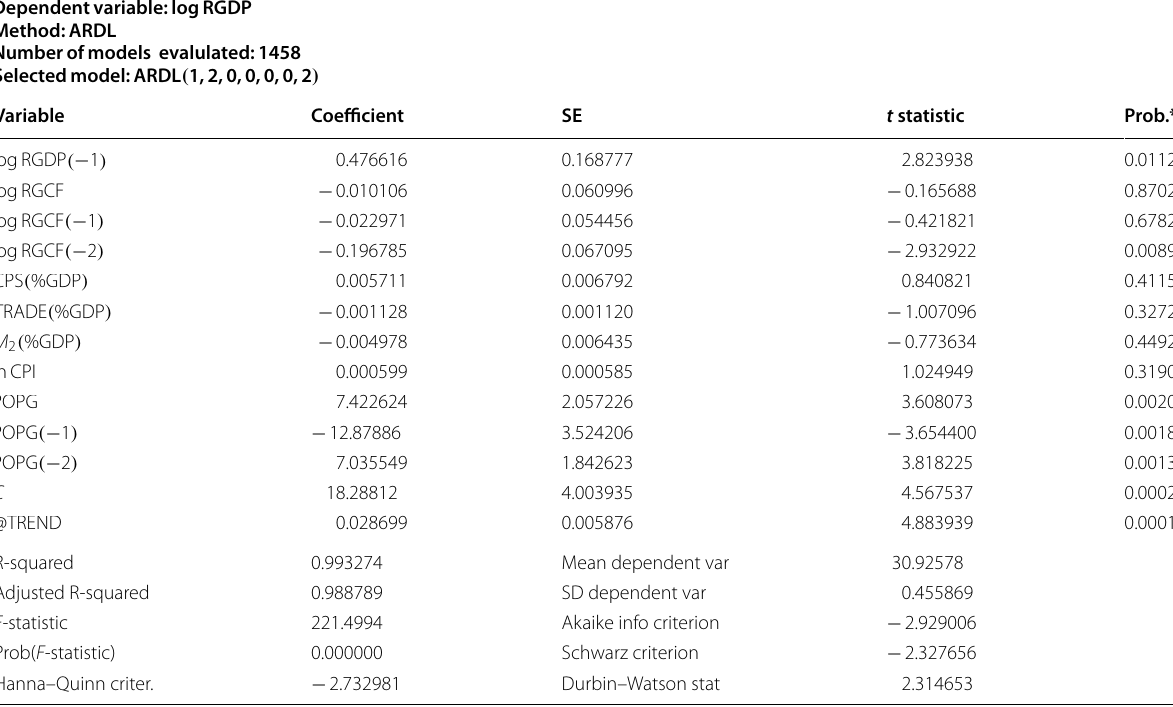
*,**,*** represents 1%, 5% and 10% respectively